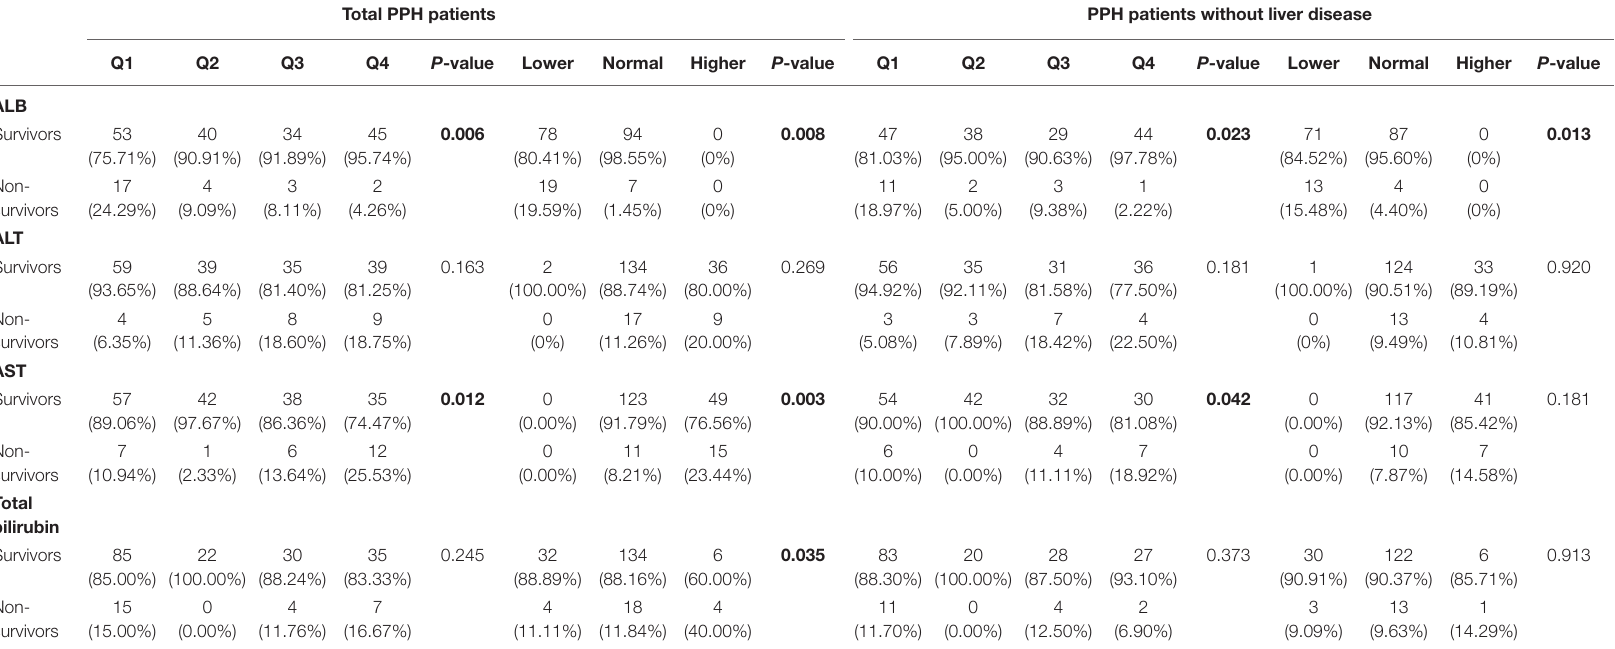
TABLE 3 | The relationship between ALB, ALT, AST, and total bilirubin with hospital